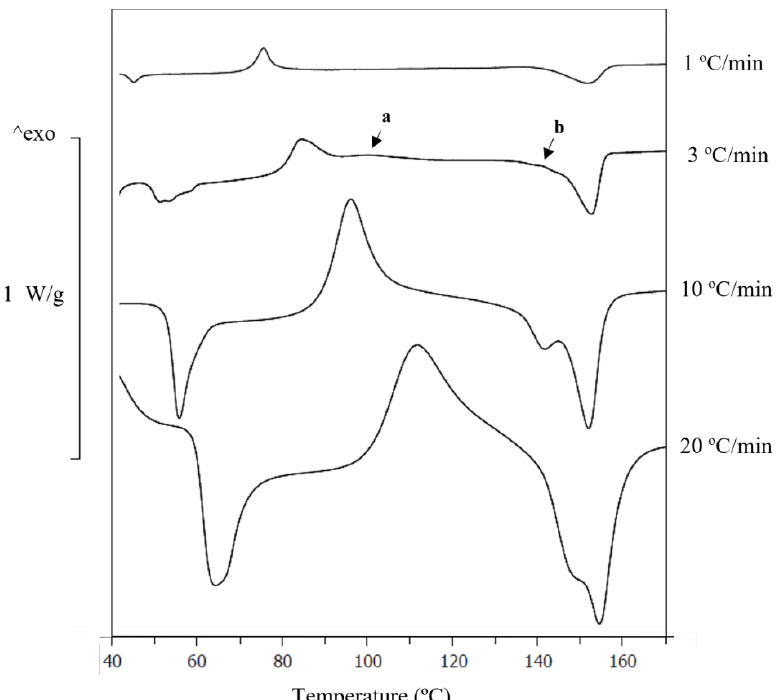
Figure 5. DSC of PLA-7.5Mg at different heating rates from 1 to 20 °C/min. Scale bar for material heated at 10 °C/min. For PLA- 7.5Mg at 3 °C/min: (a) α crystallisation, (b) transformation of α′ into α at the same time α′ is melting. Table 2. Thermal properties of the extruded 1D PLA and PLA-Mg filaments. T g : glass transition; T ER : enthalpic relaxation temperature; ΔH ER : enthalpy of enthalpic relaxation; T CC . α ′ and T CC . α : cold crystallisation temperature of α′ and α crystals, respectively; T m . α ′ and T m . α : melting temperature of